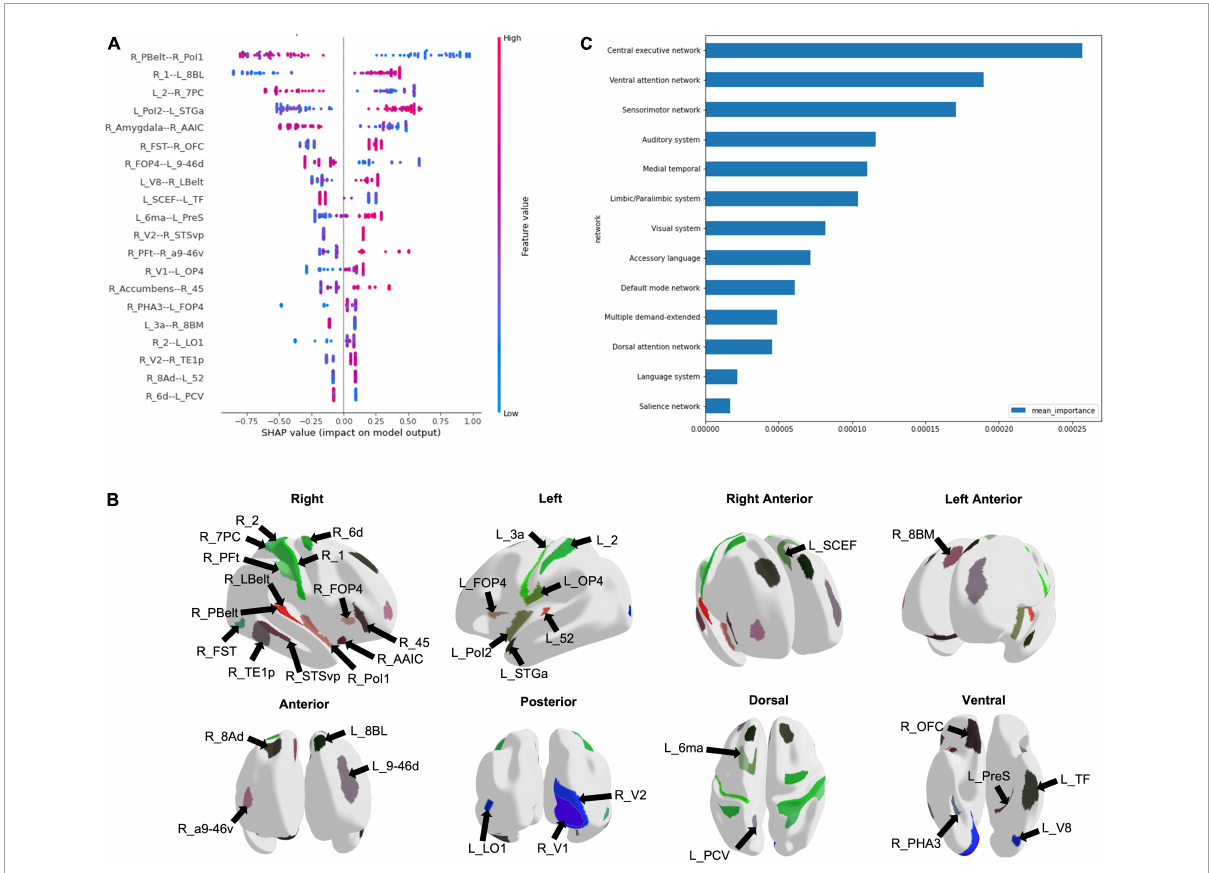
FIGURE1 Machine learning modeling to classify subjects into Insomnia disorder and controls. (A) The functional connectivity among 39 brain regions comprised the top 20 features of the model, depicted here in a SHAP plot. The x-axis depicts the impact of each feature on the model output, while the color of each data point indicates whether a high or low functional connectivity is associated with the output. (B) The regions are demonstrated on a model brain. (C) The graph demonstrates the mean importance of each network on the model’s